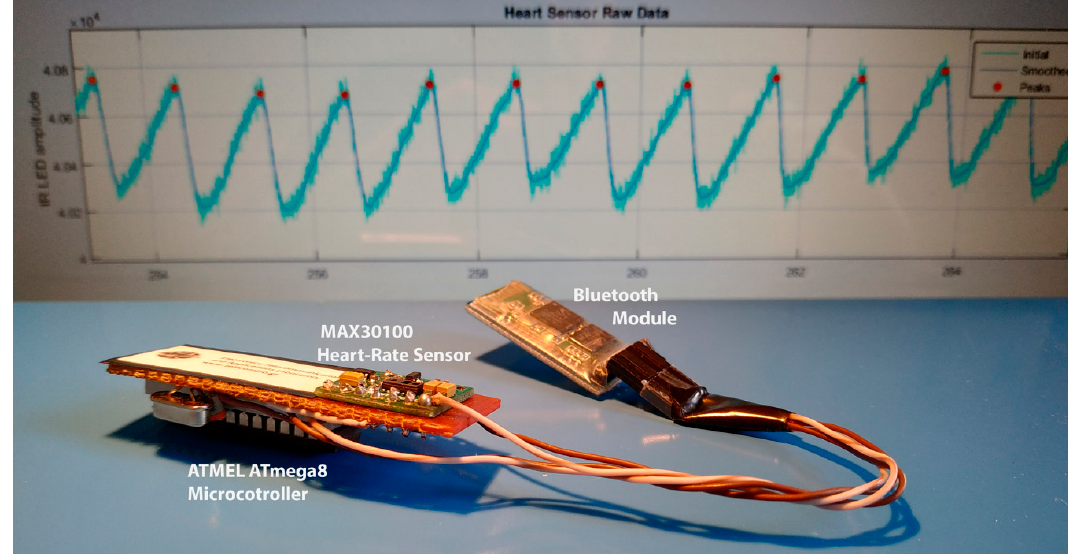
Figure 3. Prototype photoplethysmography electronic device.